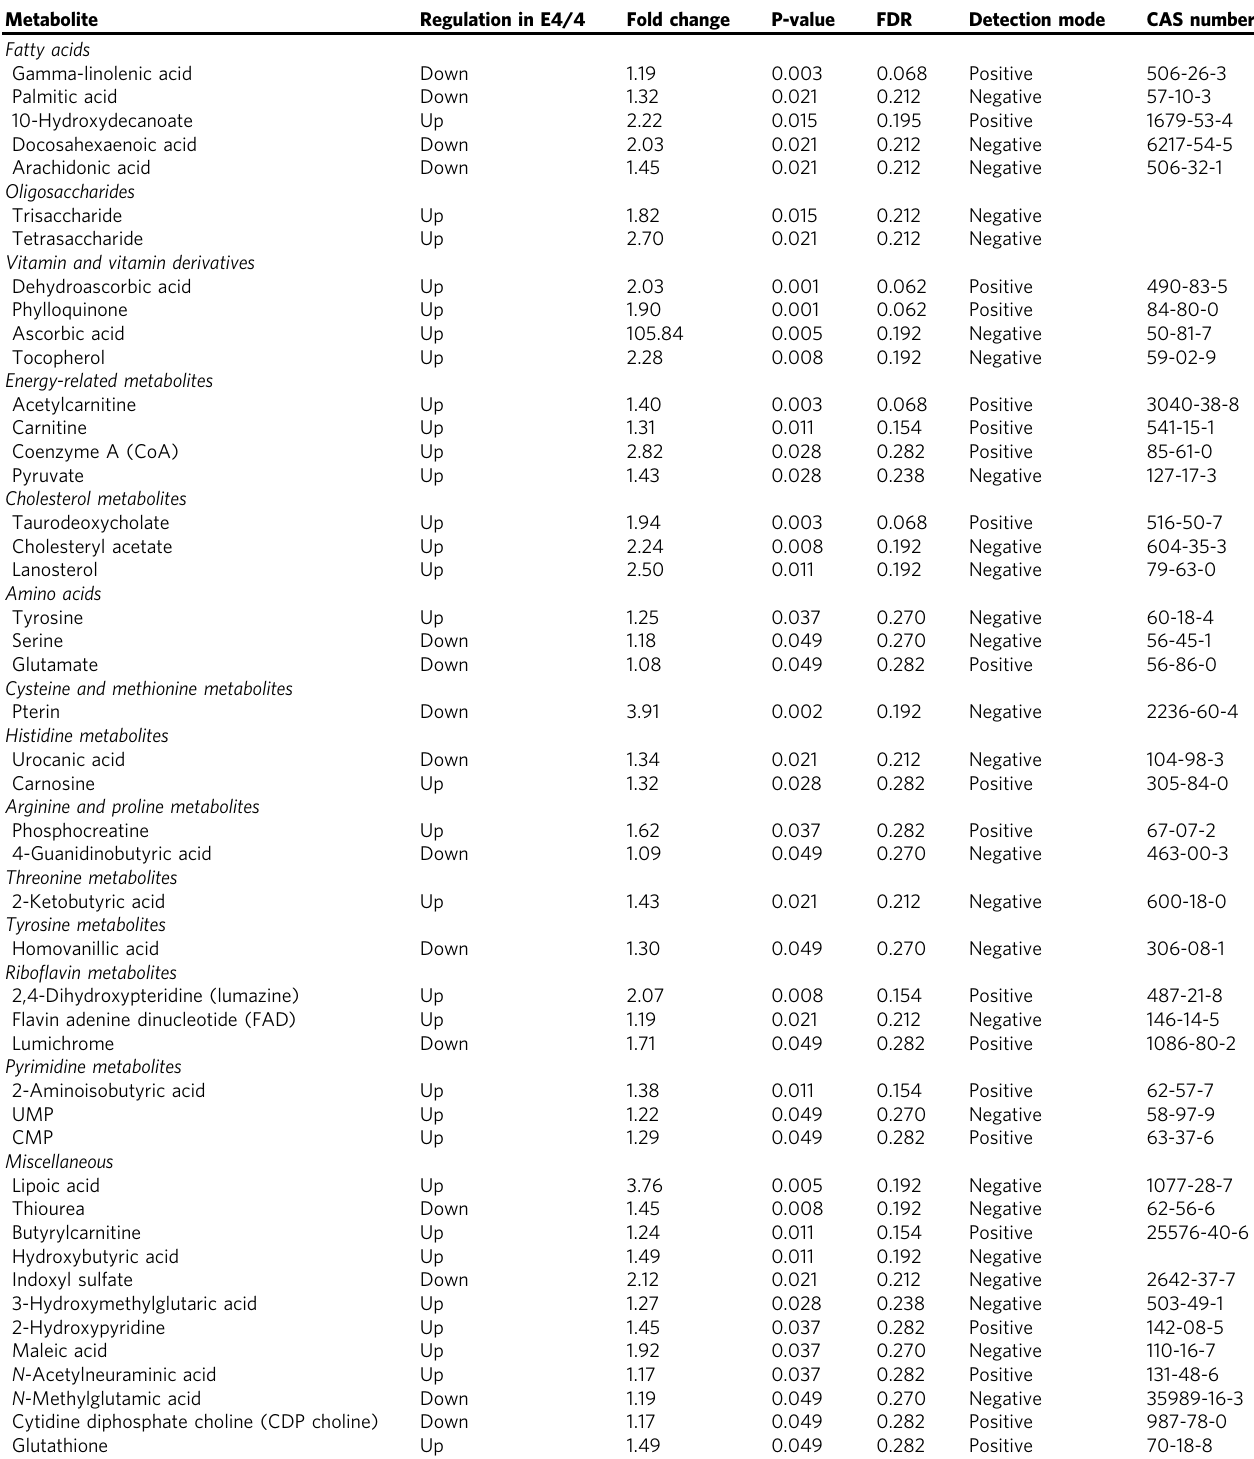
Table 2 Differentially expressed targeted metabolites from the PVC of APOE4 vs. APOE3 mice